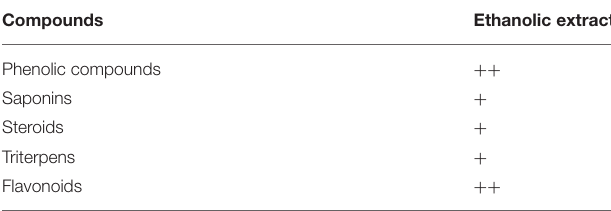
TABLE 1 | Phytochemical screening of EEPLM leaves. Compounds Ethanolic extract Phenolic compounds ++ Saponins + Steroids + Triterpens